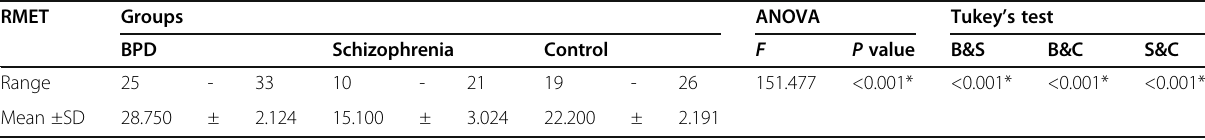
Table 2 Comparison of RMET mean score between the studied groups RMET